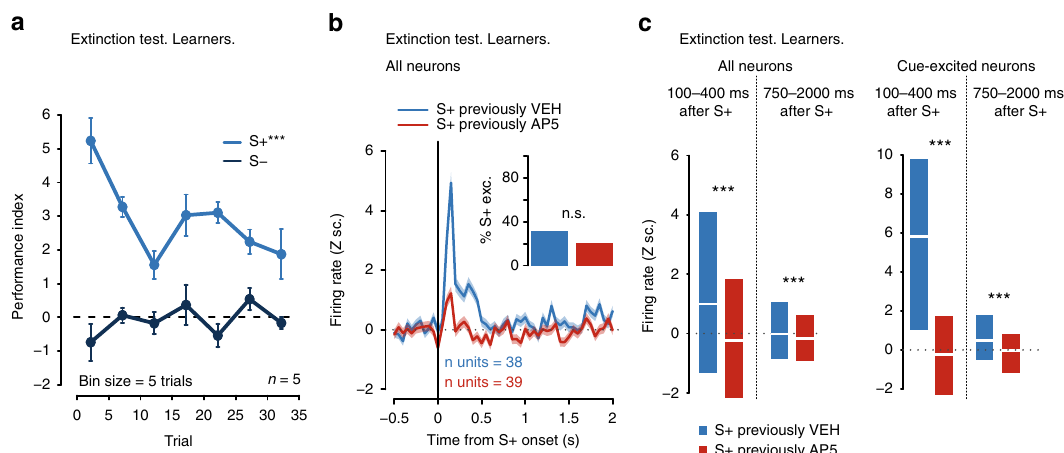
Fig. 8 The effects of AP5 on NAc fi ring outlast the presence of the drug in the brain. Data from drug-free extinction sessions of rats that received unilateral AP5 infusions during training and learned the task (Learners). VEH: vehicle. a Mean ± SEM performance on S + (light blue) and S − (dark blue) trials. Main effects of cue and cue × bin interaction (Supplementary Table 1). b Mean ± SEM fi ring activity in Z scores (Z sc.) around S + onset in NAc neurons treated with saline (blue) or AP5 (red) during training. Inset: proportion of neurons that were classi fi ed as cue-excited in the side previously treated with saline (blue) or AP5 (red) ( p = 0.31, Fisher). c Activity (median and interquartile range) 100 – 400 ms or 750 – 2000 ms after S + onset in the NAc that had been treated with saline (blue) or AP5 (red) during training. All neurons (left) vs. cue-excited neurons (right)